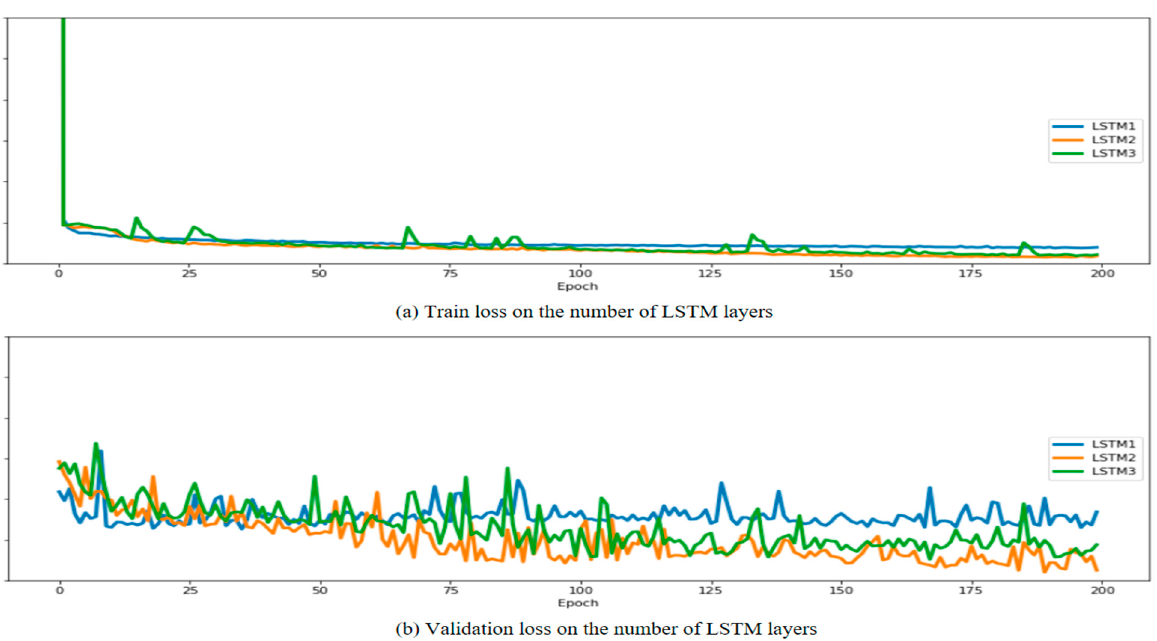
Figure 10. Train and validation loss values according to the number of GRU layers. ( a ) Train loss on the number of GRU layers; ( b ) validation loss on the number of GRU layers.